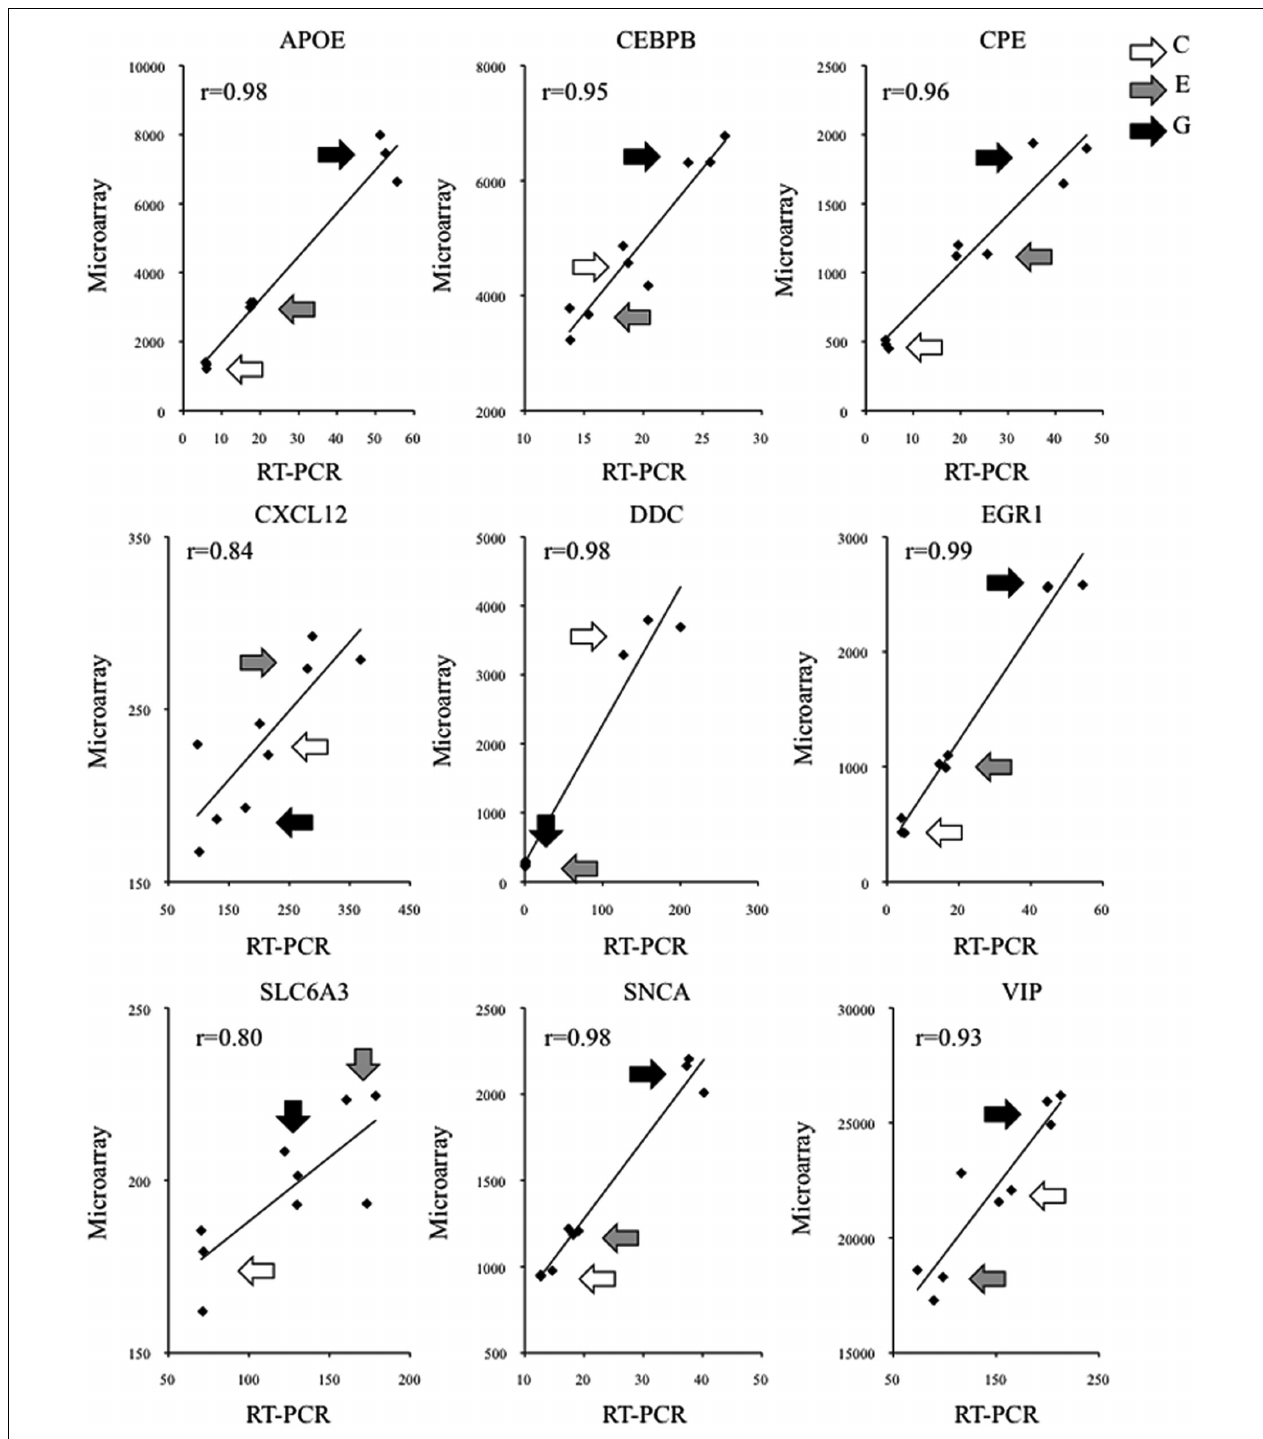
microarray and qRT-PCR assays are shown (microarray intensity values on y axis, qRT-PCR data reported on x axis in arbitrary units). For each transcript, corresponding Pearson r values are indicated; data were significantly correlated (one-tailed p ≤ 0.005). Different shaded arrows indicate biological triplicates of the clonal lines (C, E, or G) from which samples were derived. Primer sequences are provided inTable S2 in Supplementary